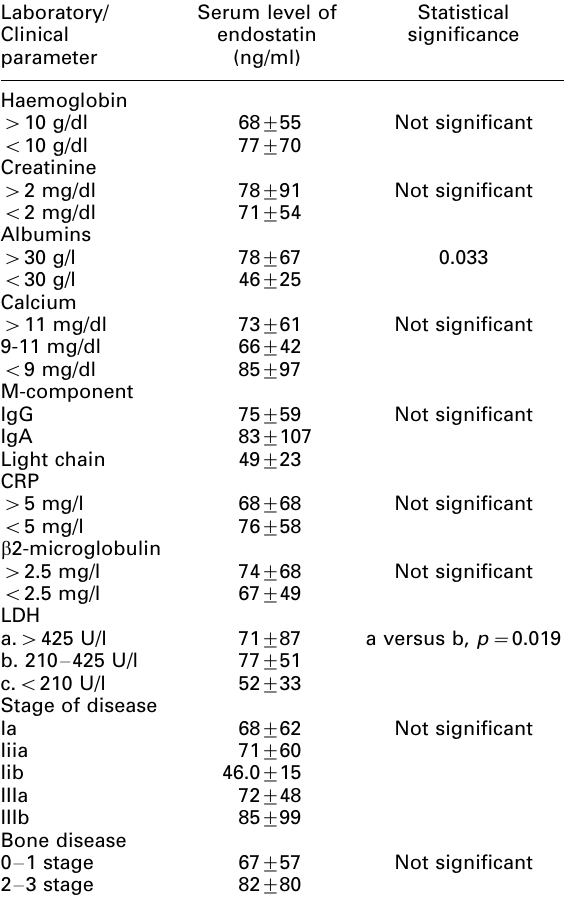
Table 3. Serum level of endostatin in MM patients correlated with clinical and laboratory